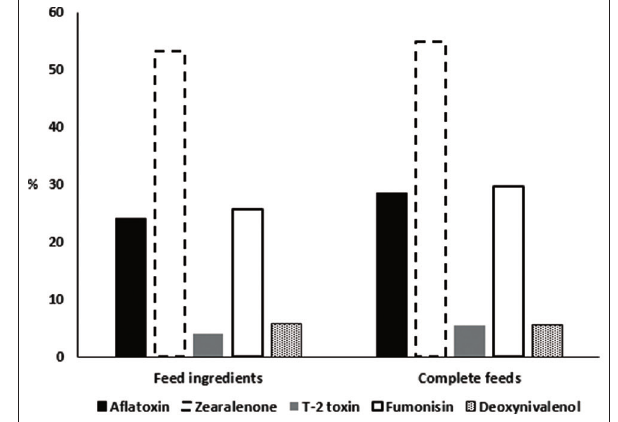
Figure-1: Prevalence of mycotoxin contamination in feed ingredients and complete feeds in the central part of Thailand from 2015 to